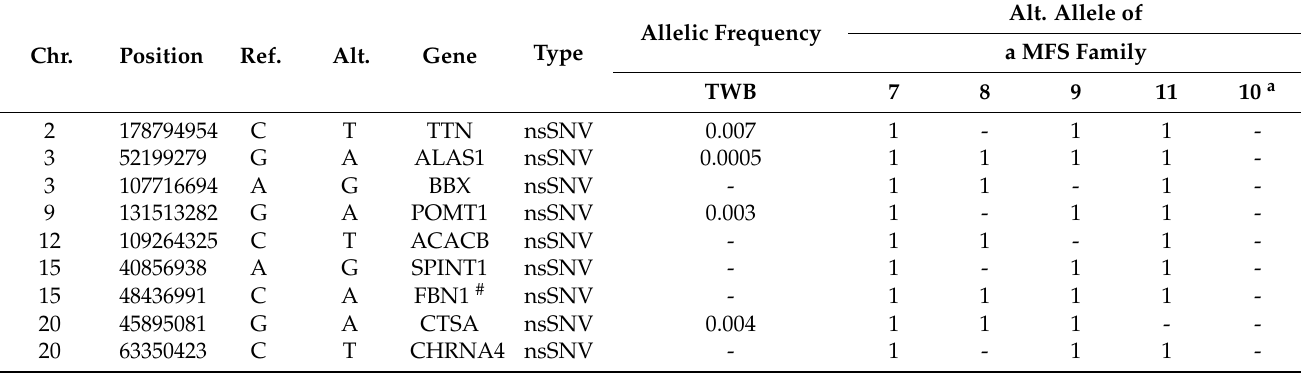
Table 5. Rare variants on MFS candidate genes shared in MFS family